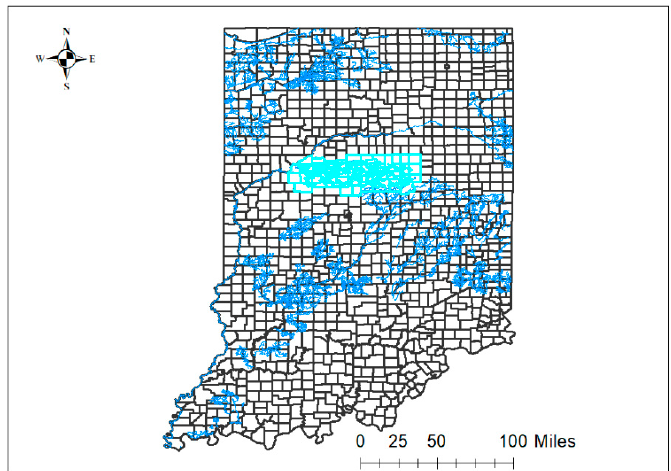
Figure 1. A map showing the location of the Wildcat Creek watershed (shaded sky-blue) in northcentral Indiana, United